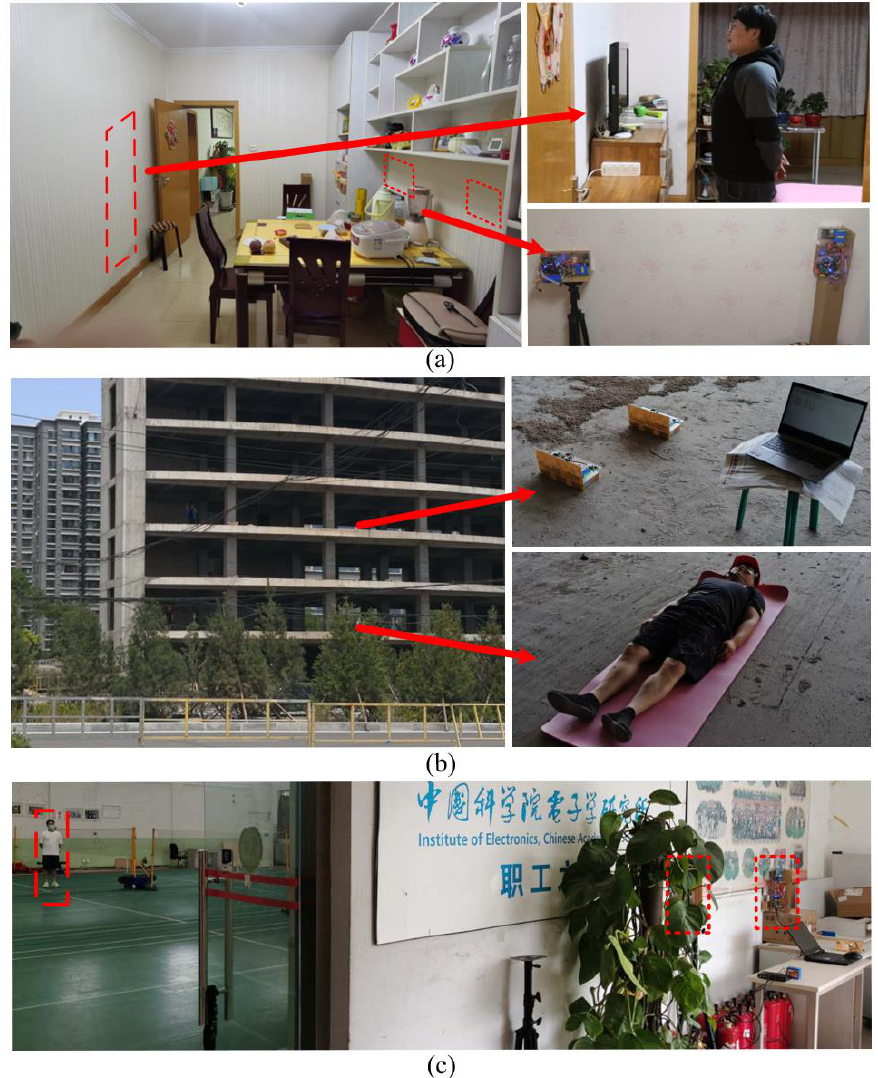
Figure 6. Experimental scenes: ( a ) type-I scene, ( b ) type-II scene, ( c ) type-III scene. Normally, the echoes from a single radar can be processed by any fast Fourier trans- form (FFT)-based respiration detection method—for example, the one in [33]—to extract the human breathing frequency. However, due to the low signal to noise ratio (SNR) in these three types of experimental scenes, as shown in Figure 7, all the output range–frequency images are too noisy to distinguish the vital sign features (VSFs). Under the architecture of the proposed multiple observation point detection system, the echoes from the two Golay complementary coded UWB life-detection radars were suitable for association processing to generate the new form of the VSF.